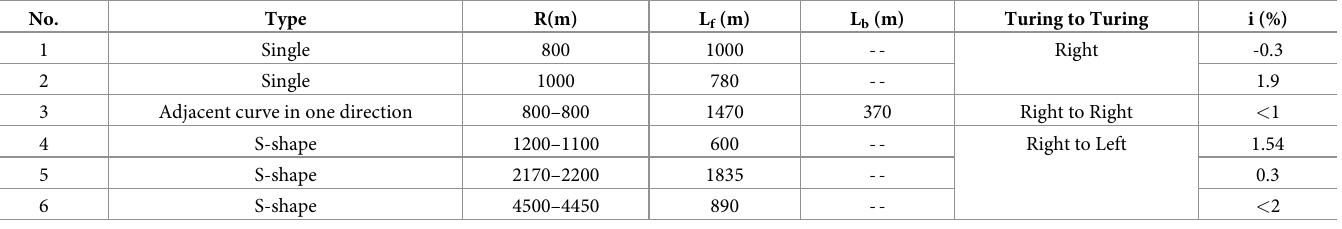
Table 2. Validation of test road